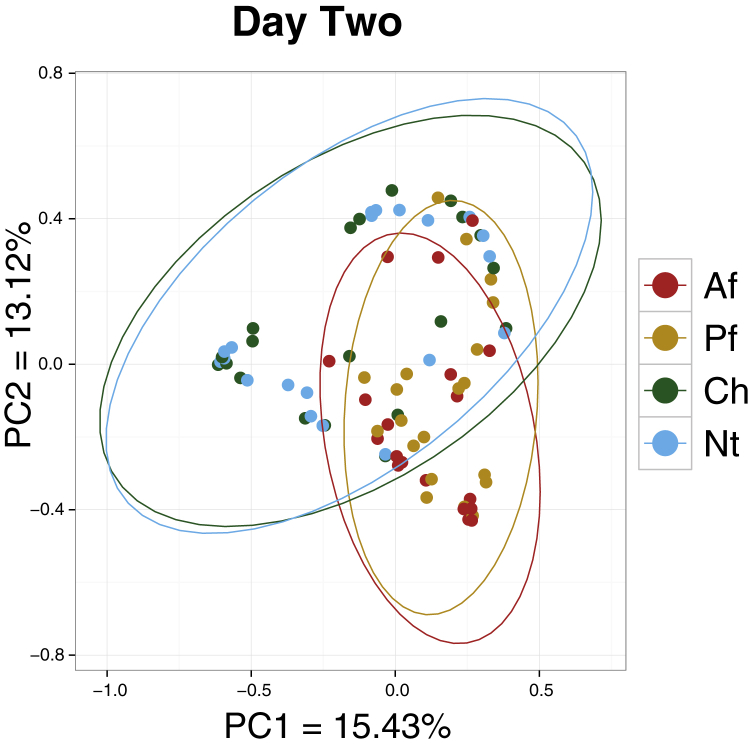
Site specificity of bacterial community composition. All samples at day 2 were clustered by using principal coordinates analysis based on theta similarity coefficients. At day 2, Af and Pf clustered together (P = 1, AMOVA), as did cheeks (Ch) and Nt (P = 1), but each clustered distinctly from the other site pair (P < .006). P values were adjusted with Bonferroni correction (n = 6).